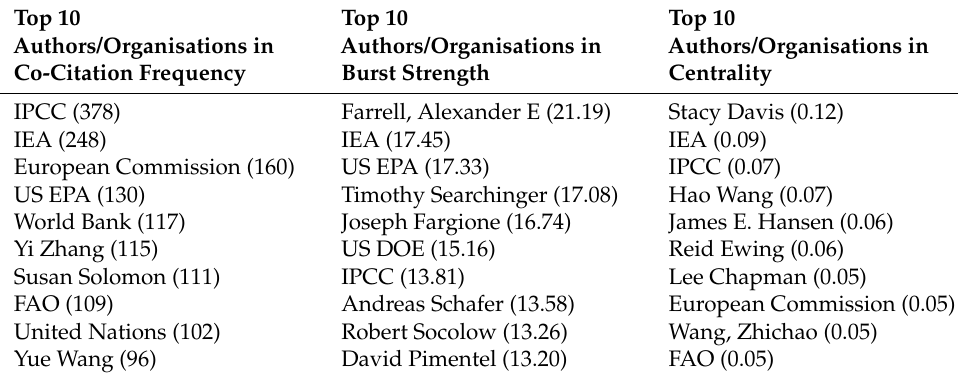
Figure 5. Author/organisation co-citation network. Table 5. Top 10 authors/organisations in co-citation frequency, burst strength, and centrality.